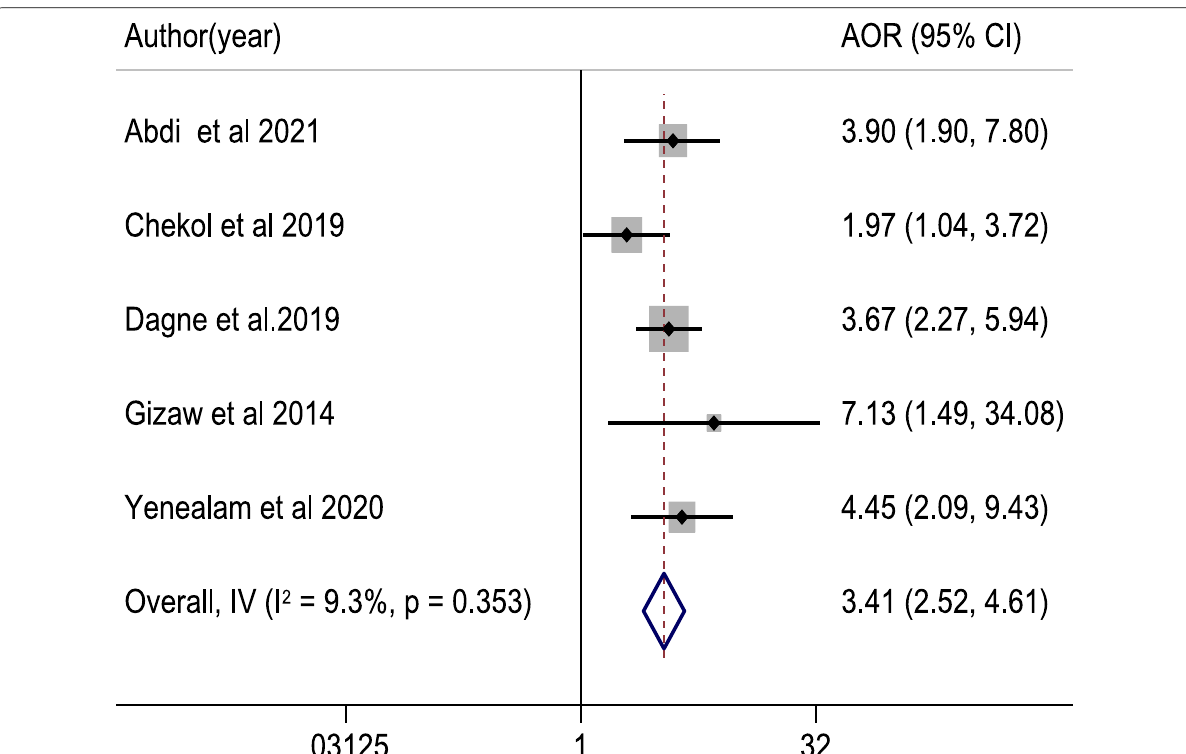
Fig. 6 The pooled adjusted odds ratio of the association between positive attitude of food handlers and food hygiene practice in